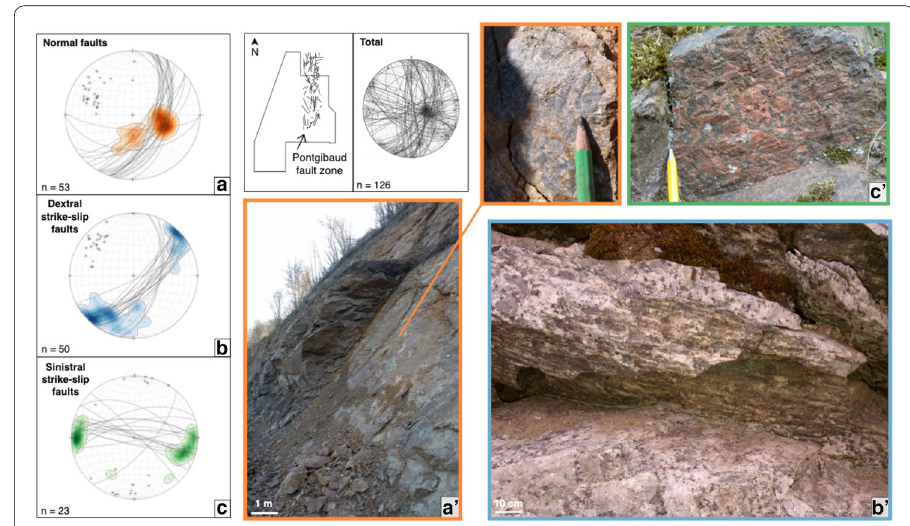
Fig. 6 Observations of the different lithologies and fault families present in the study area. a ′ , c ′ Metamorphic series. b ′ Granite. Schmidt’s projection on the lower hemisphere ( a – c ). Isodensity obtained with Stereonet (TLS‑Geothermics,